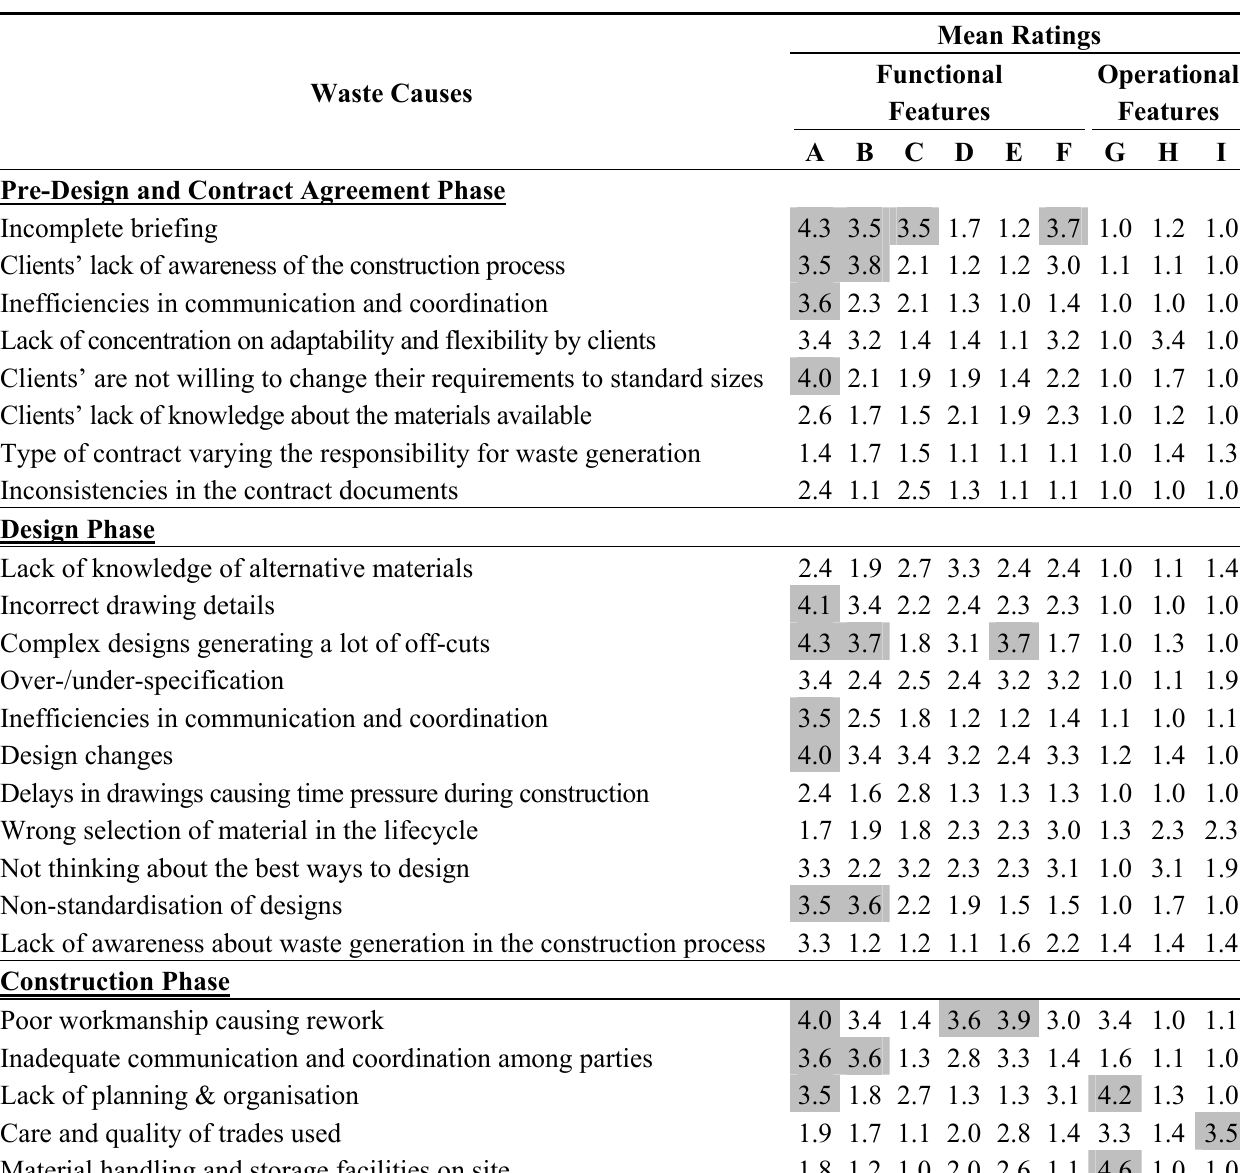
Table 3. Impact of healthcare complexities on construction waste causes and origin. (Shadow part shows highly impacted waste causes due to healthcare